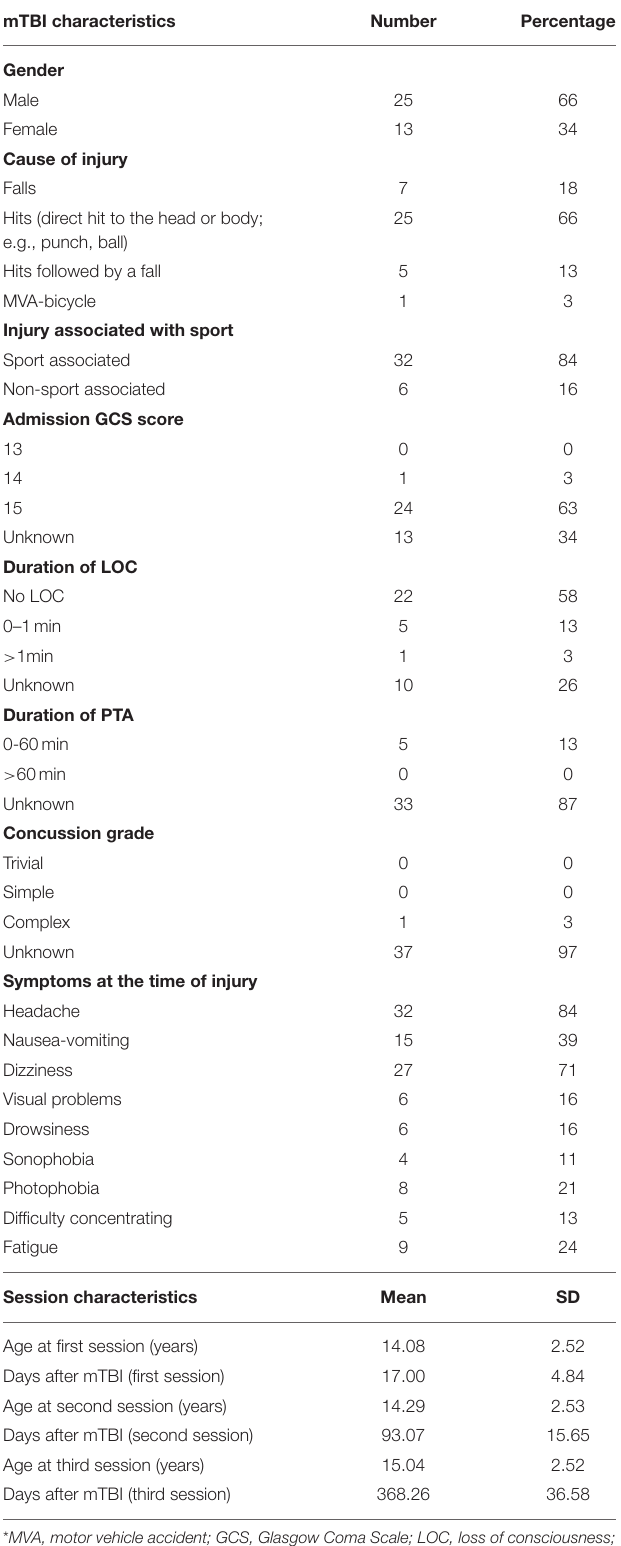
TABLE 1 | Characteristics of mTBI participants. mTBI